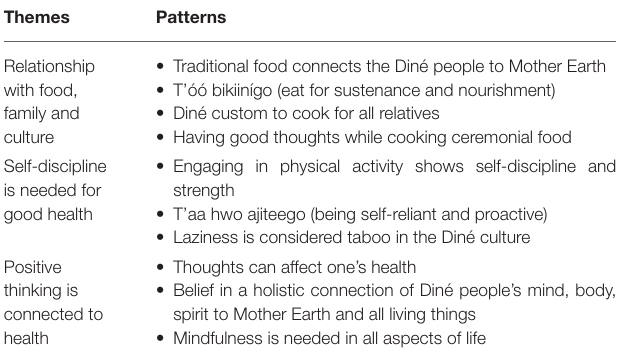
TABLE 4 | Themes from key informant